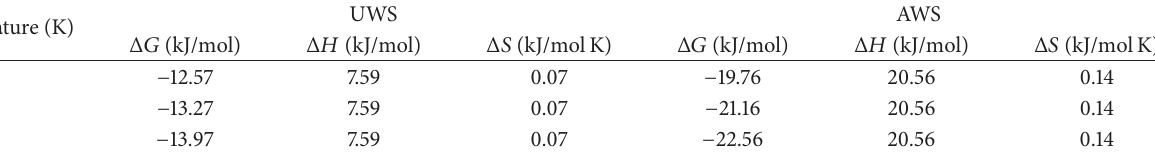
Table 2: Thermodynamic parameters for the adsorption of Cu(II).